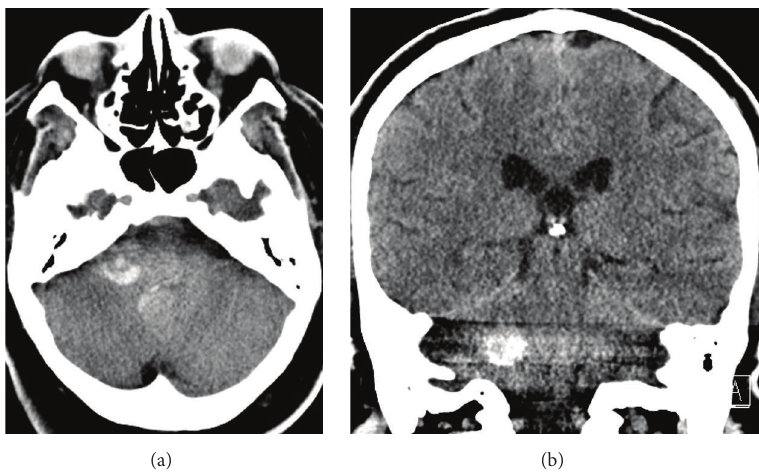
Figure 1: Axial (a) and coronal (b) noncontrast computed tomography (CT) of the head demonstrates hemorrhage in the region of the inferior right cerebellar peduncle, which appeared intraparenchymal, with extension into the fourth ventricle.